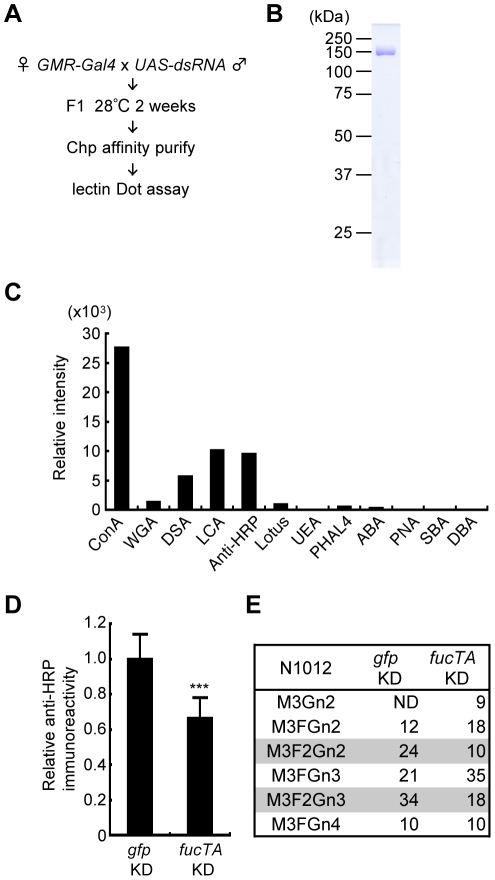
Screening strategy and validation of the primary screen for genes whose knockdown impairs glycosylation.(A) Outline of screen design. (B) Coomassie Brilliant Blue (CBB) staining of Chp affinity-purified with anti-Chp antibody and separated by SDS-PAGE. Chp could be purified as a single band (∼150 kDa) by a single step of affinity purification. (C) Binding abilities of glycan probes to purified Chp. The signal intensities normalized to the amount of Chp are represented. (D) Anti-HRP antibody reactivity normalized to Chp levels was decreased in fucTA knockdown flies (fucTA KD) compared to that in control gfp knockdown flies (gfp KD). Results are the mean ± SD of 4 experiments. ***p<0.005. (E) Glycan structures attached to N1012 of Chp revealed by mass spectrometry analysis. Percentages of each structure in the control (left, gfp KD) and fucTA knockdown conditions (right, fucTA KD) are listed. The glycans bearing α1,3-fucose are highlighted (gray). Schematic structures are represented in Figure S3. M, mannose; F, fucose; Gn, N-acetylglucosamine. ND, not detected.